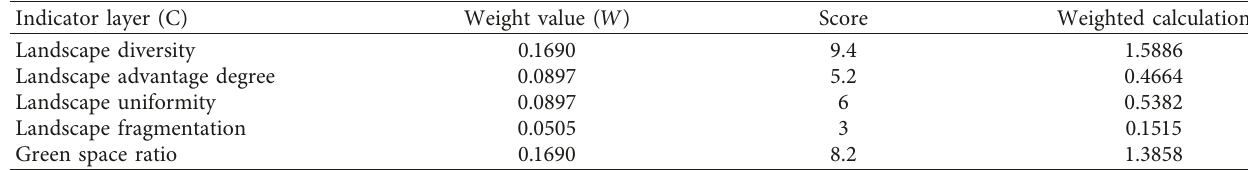
Table 11: Calculation result of the weighted ecological landscape index of Jingfeng high-speed extension Chong section.